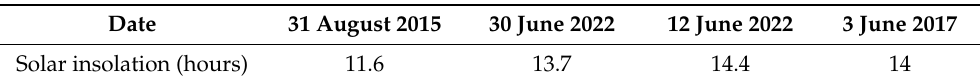
Figure 2. Skew-t vertical profiles from the Gánovce areological center representing the vertical distribution of humidity (dewpoint, left black line), temperature (right black line) and windspeed (windbarbs on the right) for ( a ) 31 August 2015 12:00 UTC, ( b ) 12 June 2022 12:00 UTC, ( c ) 30 June 2022 12:00 UTC and ( d ) 3 June 2017 12:00 UTC. Table 2. Solar insolation hours measured at the airport for all four scenarios.